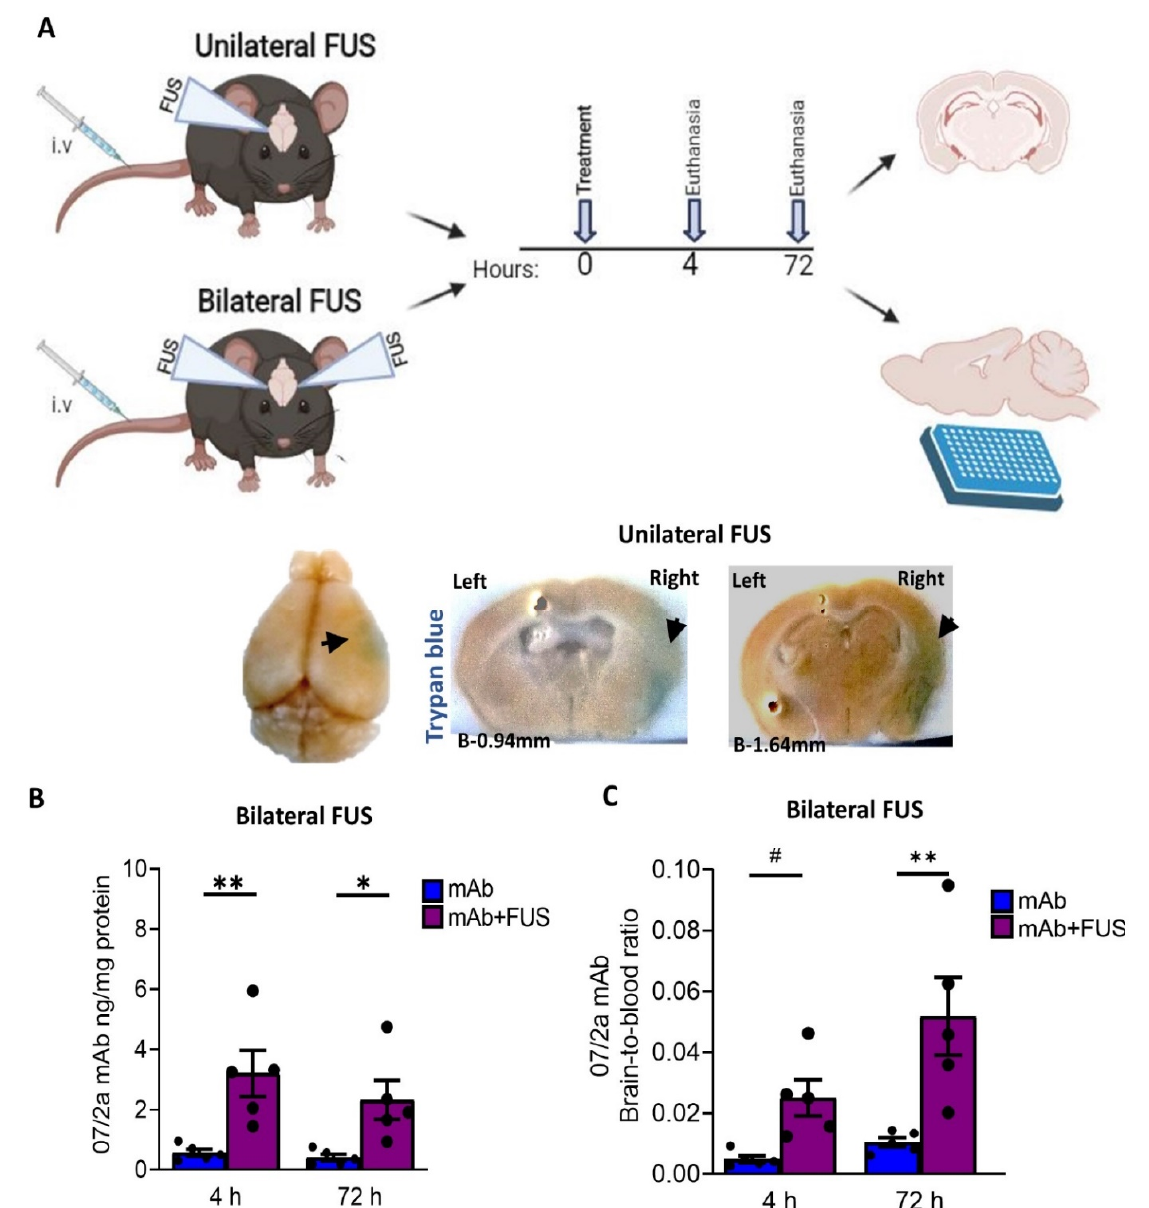
Figure 1. Study overview and the bioavailability of the 07/2a mAb in the brain ( A ) Experimental design and timeline of the experiment (image generated using BioRender). For unilateral FUS, 24 months old APP PS1dE9 mice were i.v. administered with single dose of 300 µg 07/2a mAb with microbubble i.v. infusion and FUS-BBBD on the brain’s right hemisphere. Mice received 2% Trypan blue dye prior to euthanasia and were taken down at 4 h ( n = 5) and 72 h ( n = 4) after mAb infusion; saline perfused and brains were collected for coronal sections. Non-sonicated left hemisphere was identified with a small needle mark. For Bilateral FUS cohort, both hemispheres received ultrasound and the same procedure has been followed but without Trypan dye injection. Collected brains were bisected; right hemispheres were used for ELISA and left hemisphere for histology. Representative pictures for trypan blue extravasation (arrows) on the sonicated right hemisphere across Bregma −0.94 mm to −1.64 mm from the unilateral FUS study. ( B ) Anti pGlu3-42 Aβ mAb levels from the half brain homogenates after 4 h and 72 h post treatment in the bilateral FUS cohort were analyzed by ELISA ( C ) Brain-to-blood concentration ratio of 07/2a mAb at 4 h and 72 h. Black dots represent data from individual mice. Data are expressed as mean ± SEM. Two-Way ANOVA, with Bonferroni’s multiple comparison test # p = 0.1, *, p < 0.05, **, p < 0.005.